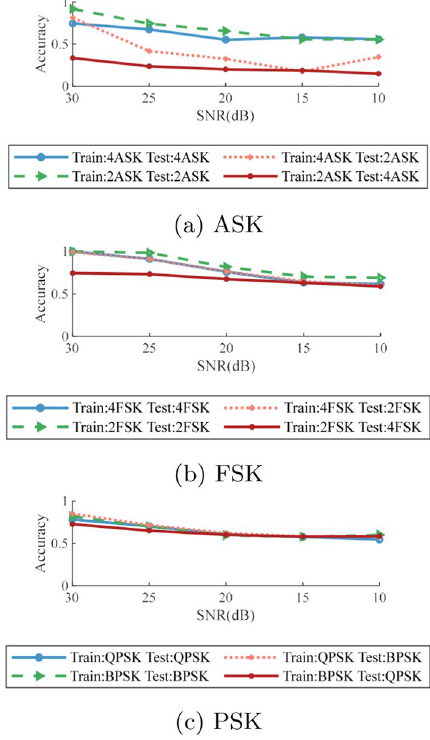
Fig. 10 Accuracy of different modulated